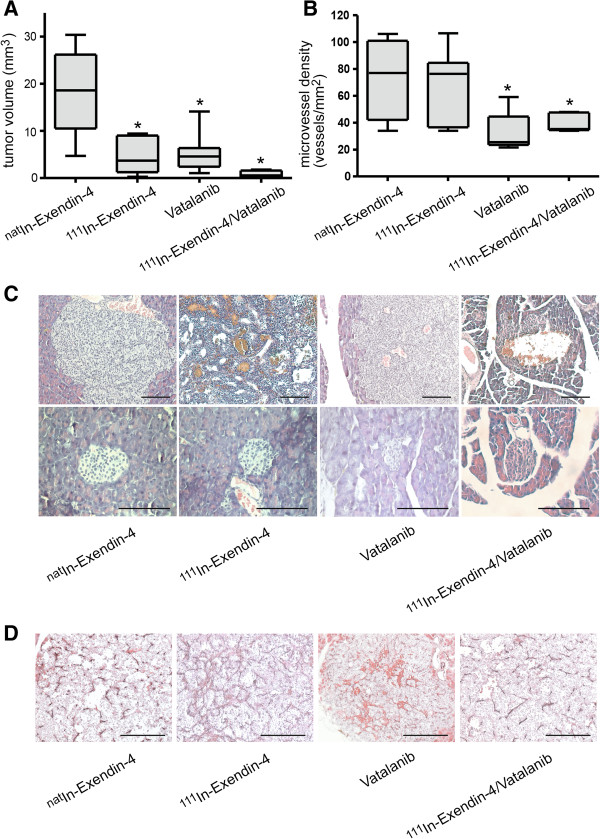
Therapeutic efficiency of combination therapy with [Lys40(Ahx-DTPA-111In)NH2]-exendin-4 and vatalanib. (A) The combination therapy reduces tumor burden by up to 97% (*p < 0.05, Kruskal-Wallis test) compared to the single-modality treatment. (B) The combination therapy and monotherapy with vatalanib reduce the microvessel density significantly compared to monotherapy with [Lys40(Ahx-DTPA-111In)NH2]-exendin-4 (p < 0.05, Newman-Keuls post-test). (C) H&E staining of tumors upon treatment. Histology confirms tumor regression in the combination therapy arm, while normal islets are unaffected. (D) CD31 immunohistochemical staining on tumor sections. Vessels persist under anti-angiogenic therapy, but vessel density is reduced. Size bars, 100 μm.